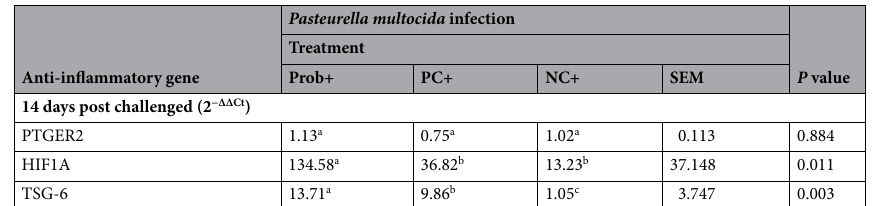
Table 8. Effect of probiotics supplementation on anti-inflammatory gene expression in caecal mucosa of Pasteurella multocida challenged broilers. Values are means of two replicates and standard errors of means. Within each variable, values with the same superscript letter are not significantly different according to Duncan’s multiple range test (P > 0.05). Pro+: challenged probiotic control; PC+: challenged positive control; NC+: challenged negative control. HIF1A hypoxia inducible factor 1 alpha, PTGER2 prostaglandin E receptor 2, TSG-6 tumor necrosis factor- (TNF) stimulated gene-6, Pro+ challenged probiotic, PC+ challenged antibiotic; NC+ challenged